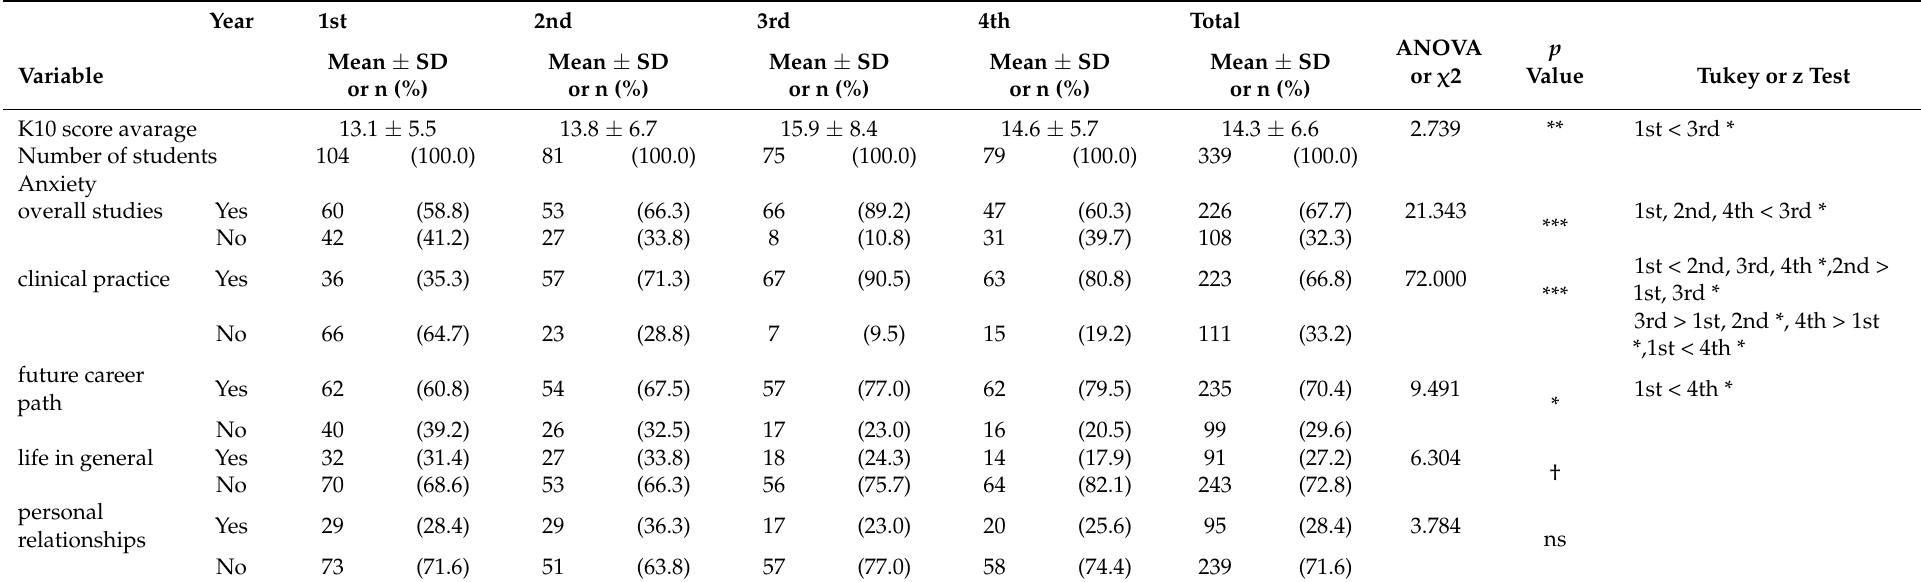
Table 1. Association between students of each year and demographic characteristics of students (N = 339).